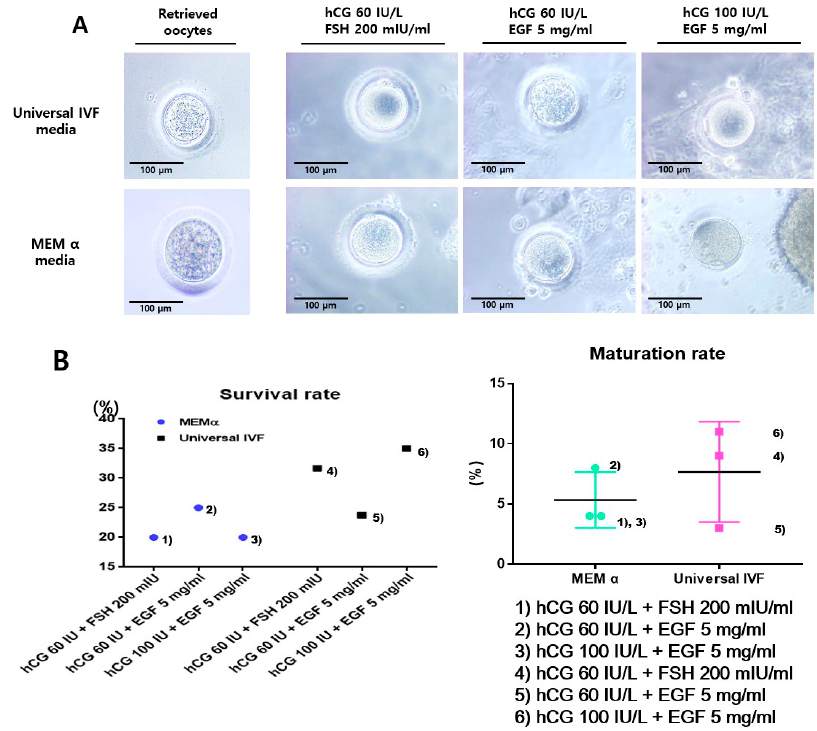
Figure 2. In vitro maturation of marmoset oocytes using different conditions. ( A ) Morphological observation of oocytes matured in various conditions. The survival rate was calculated based on the health status of oocytes, and the degenerated oocytes during the maturation process were considered as dead. After 36 h, oocytes with polar bodies were ascertained as matured oocytes. ( B ) Survival and maturation rates of in vitro matured oocytes. Among the maturation conditions, ‘condition (6)’ as mentioned in the methods section was the most efficacious in regard to the survival and maturation of